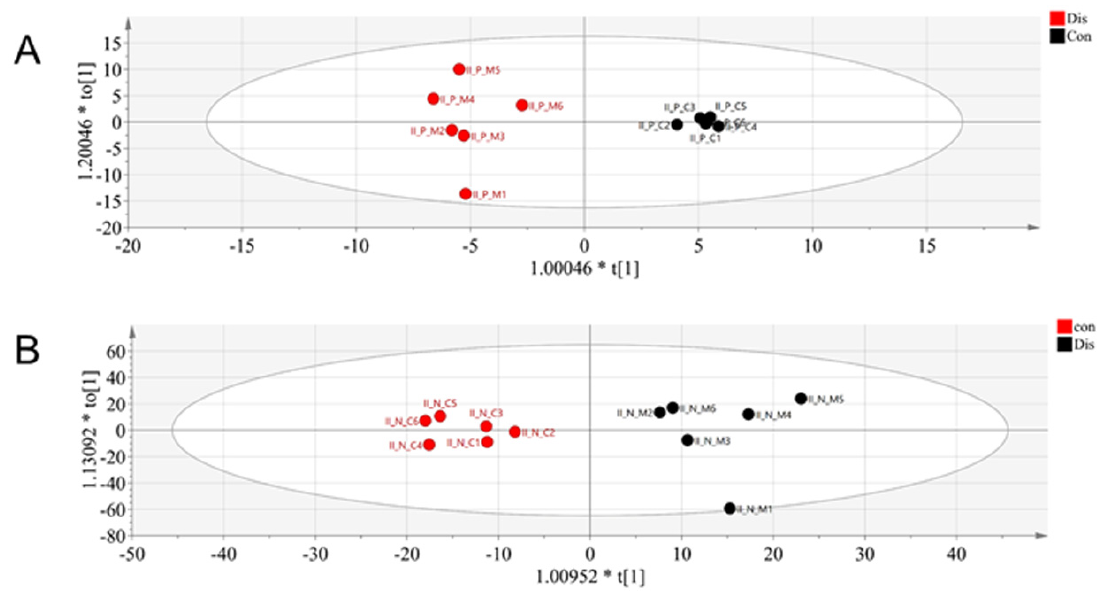
Figure 2. PCA analysis of OA group and control group: ( A ) in positive ion mode and ( B ) in negative ion mode.